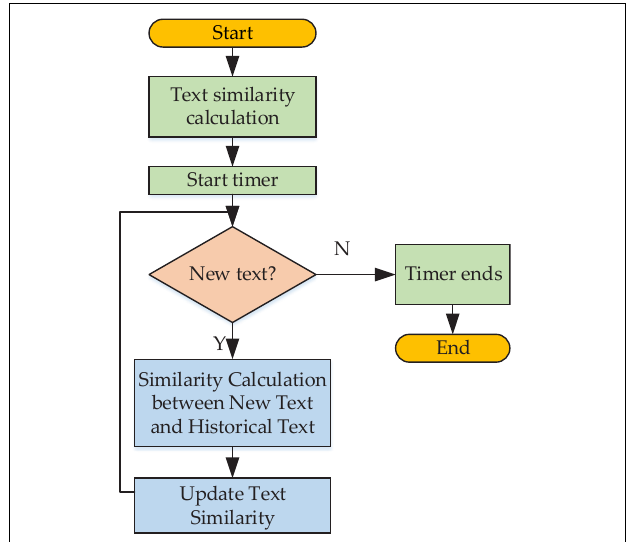
FIGURE 7 | Working flowchart of the text-similarity calculation module.